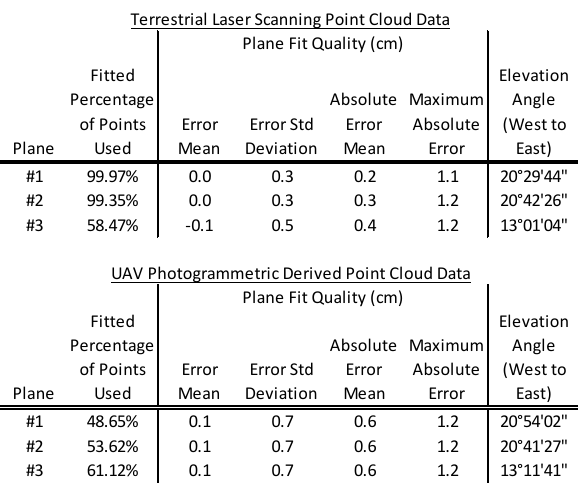
Table 3. Plane-fitting results for TLS and UAV for building 1 . The UAV point cloud exhibited noise with range of about 15cm. Also, there was a vertical bias of approximately 8cm between points on the roof of building 1 (Figure 5).